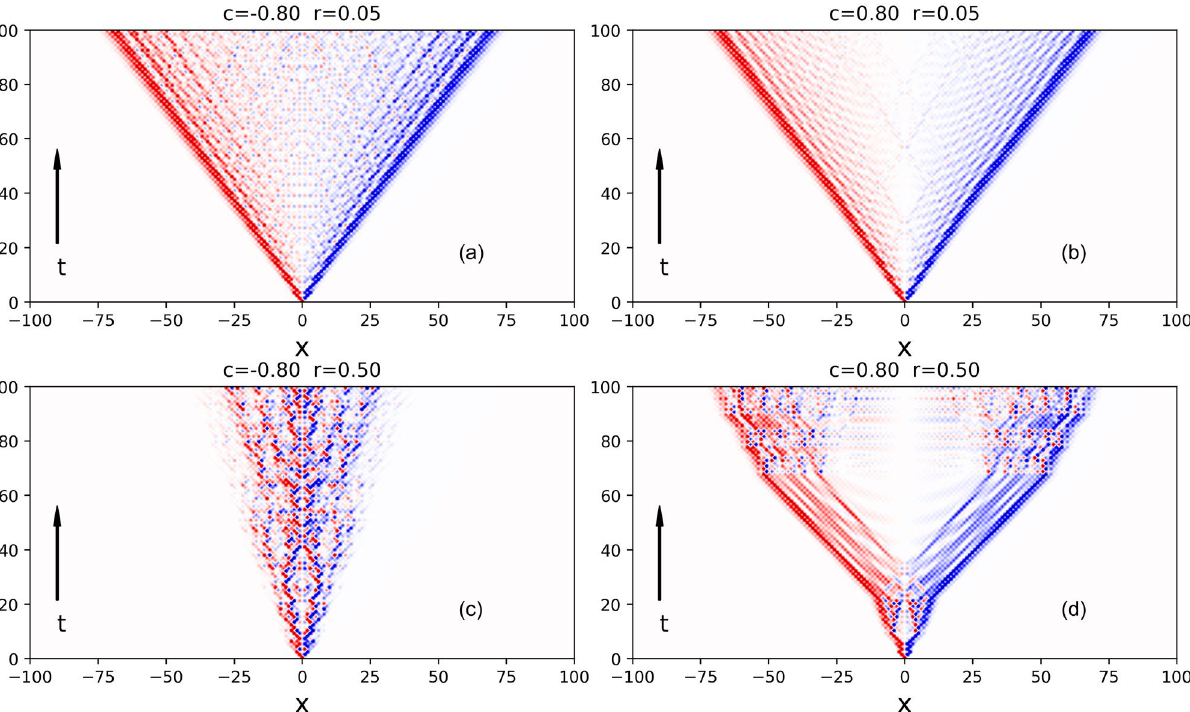
max for r A t 0.05, 0.5 and correlation | | = { } ψ U t ( x ) . In both cases, the | |